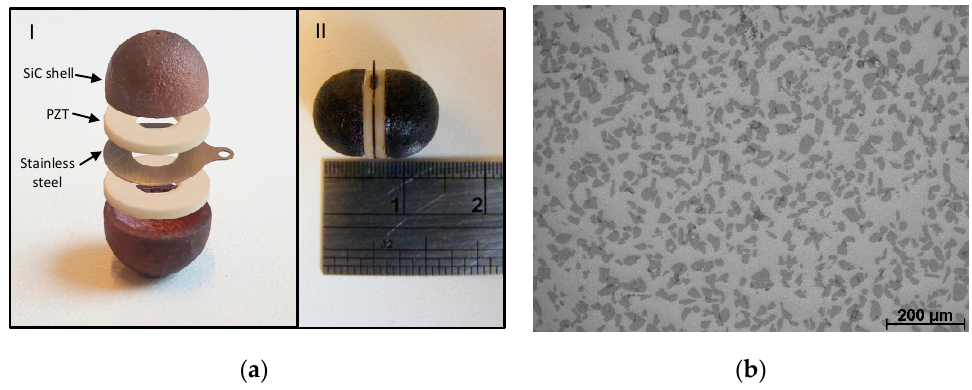
Figure 1. ( a ) The structure of the transducer before (I) and after (II) assembly.; ( b ) Microstructure of the produced material, with Si (light grey matrix) and α -SiC (dark grey